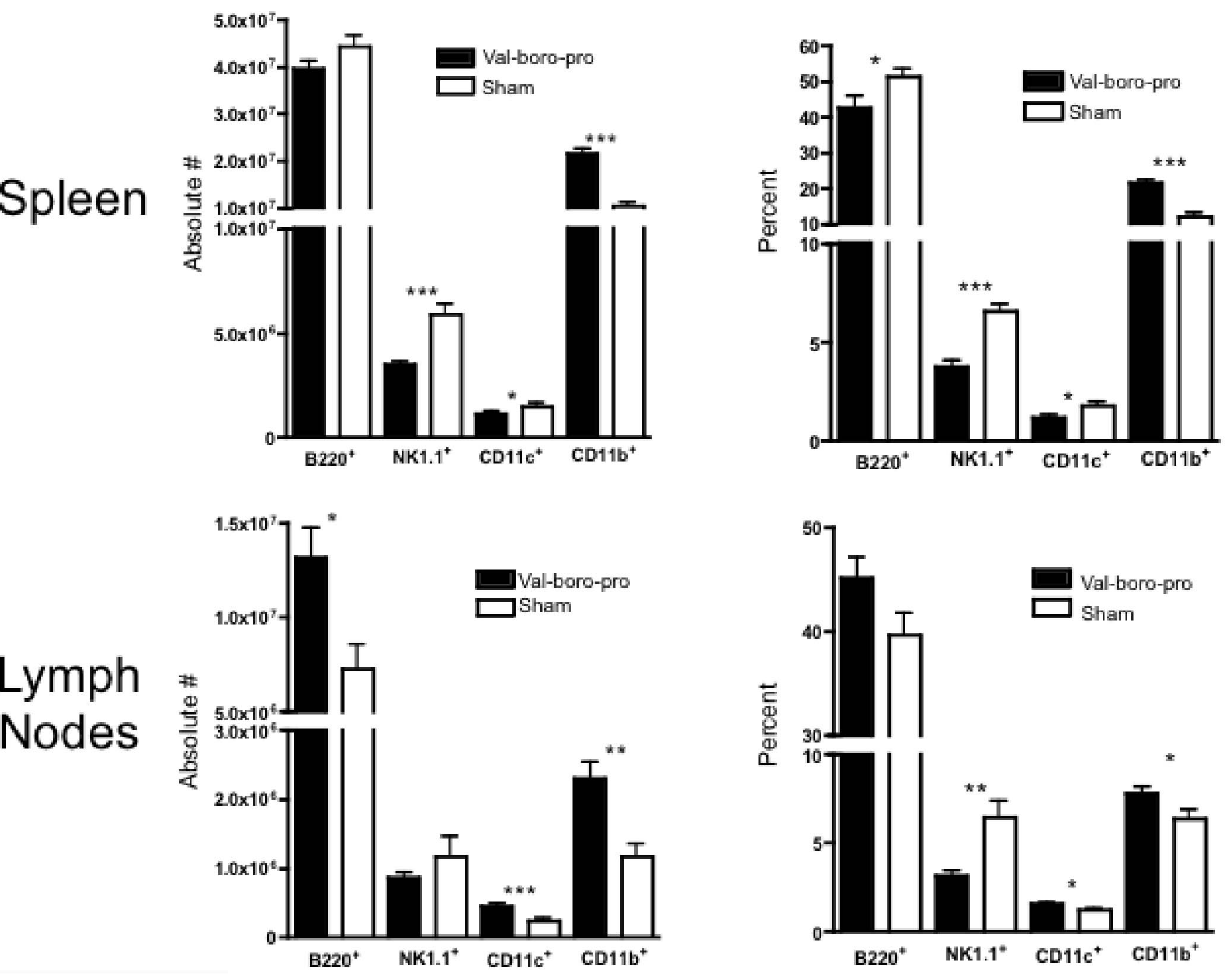
Figure 6. Treatment with Val-boroPro alters lymphocyte and myeloid cell population in secondary lymphoid tissues. C57BL/6 mice were treated with 20 m g Val-boroPro (solid bars) or saline (open bars) 5 6 /week for four weeks, and spleens (n=15/group) and lymph nodes (n=8/ group) were harvested and analyzed by flow cytometry. ( *p , 0.05, **p , 0.01, ***p , 0.001 and reflect comparisons between Val-boroPro treated and Saline treated groups by Mann-Whitney). Figure 6 was conducted twice.